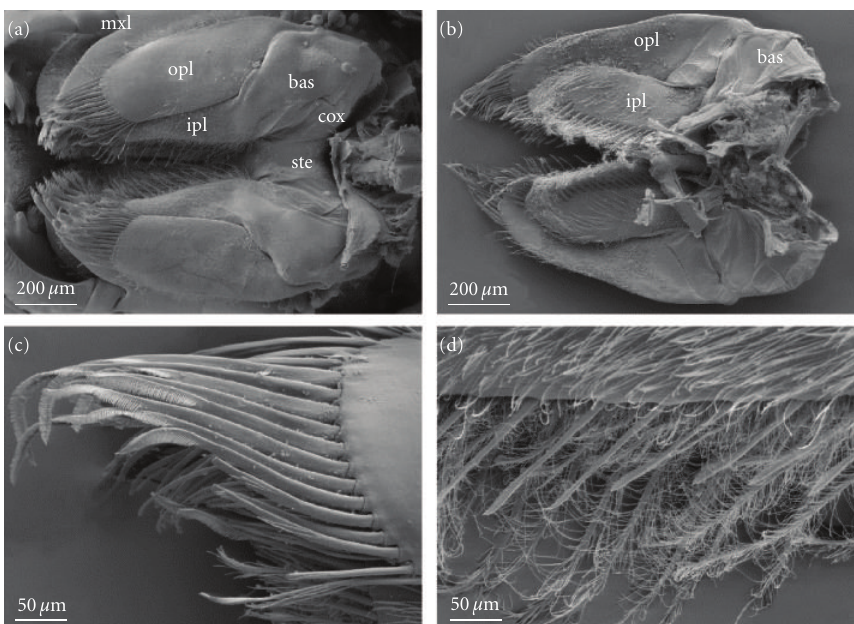
Figure 8: SEM images of maxillae of Gammarus pulex : (a) maxillae in situ in posterior view; (b) maxillae in anterior view; (c) distal setation of outer plate of left maxilla in posterior view; (d) median setation of inner plate of left maxilla in posterior view. Abbreviations other than in previous figures: ipl: inner plate; mxl: maxillula; opl: outer plate; ste: sternite.